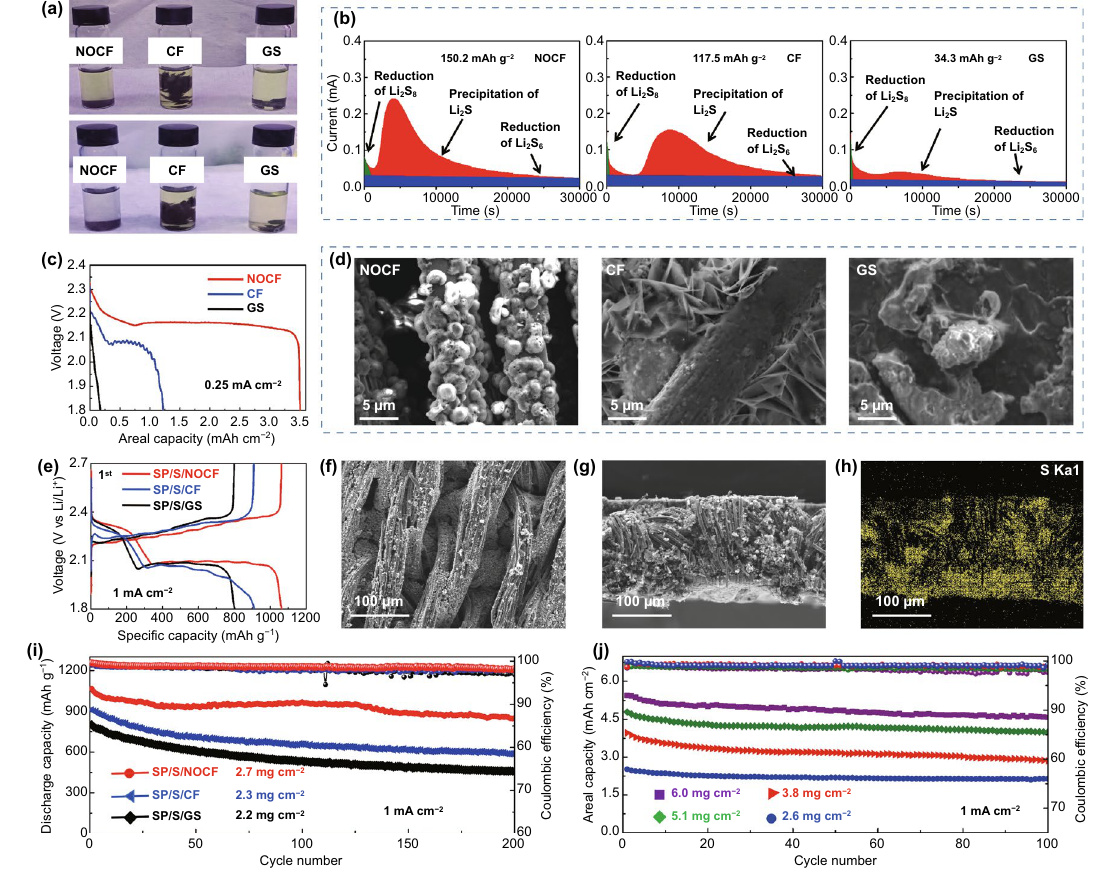
Fig. 4 a Photographs showing the starting (top photo) and ending (bottom photo) states of Li 2 S 8 adsorption onto NOCF, CF, and graphite sheets (GS). b Potentiostatic discharge profiles of cells with NOCF, CF, and GS. c Galvanostatic discharge curves of NOCF, CF, and GS (vs. Li foil) with a certain amount of Li 2 S 8 catholyte at 0.25 mA cm −2 . d Corresponding SEM images of Li 2 S deposition at the surface of various substrates, including NOCF, CF, and GS. e The first charge/discharge cycle of various sulfur cathodes (SP/S/NOCF, SP/S/CF, and SP/S/GS) at 1.0 mA cm −2 . f–h Top-view and cross-section SEM images of SP/S/NOCF and the corresponding sulfur mapping. i Cycling performance of SP/S/NOCF, SP/S/CF, and SP/S/GS cathodes at 1 mA cm −2 . j Cycling performance of SP/S/NOCF cathodes with various sulfur